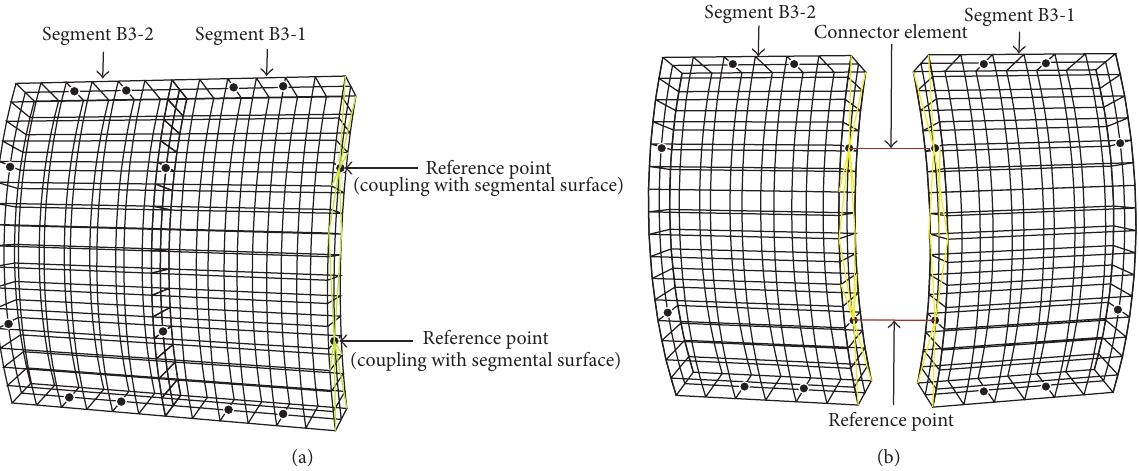
Figure 7: “Node-to-surface coupling” and the arrangement of reference points and connector element (e.g., segments B3-1 and B3-2) (a) without relative movement between adjacent segments and (b) with relative movement between adjacent segments.